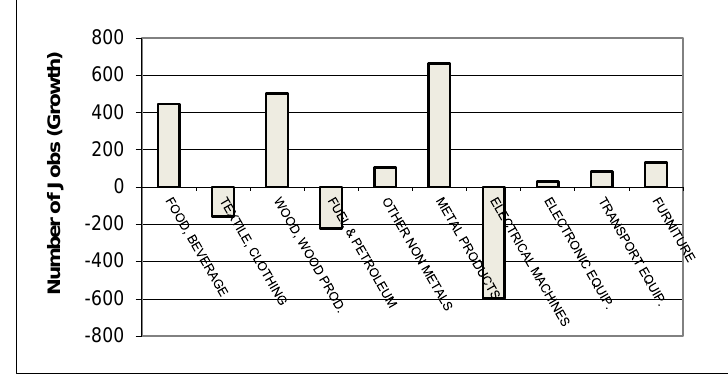
FIGURE 2: Employment growth in the Platinum SDI Source: Rex Database, 2011 – Authors’